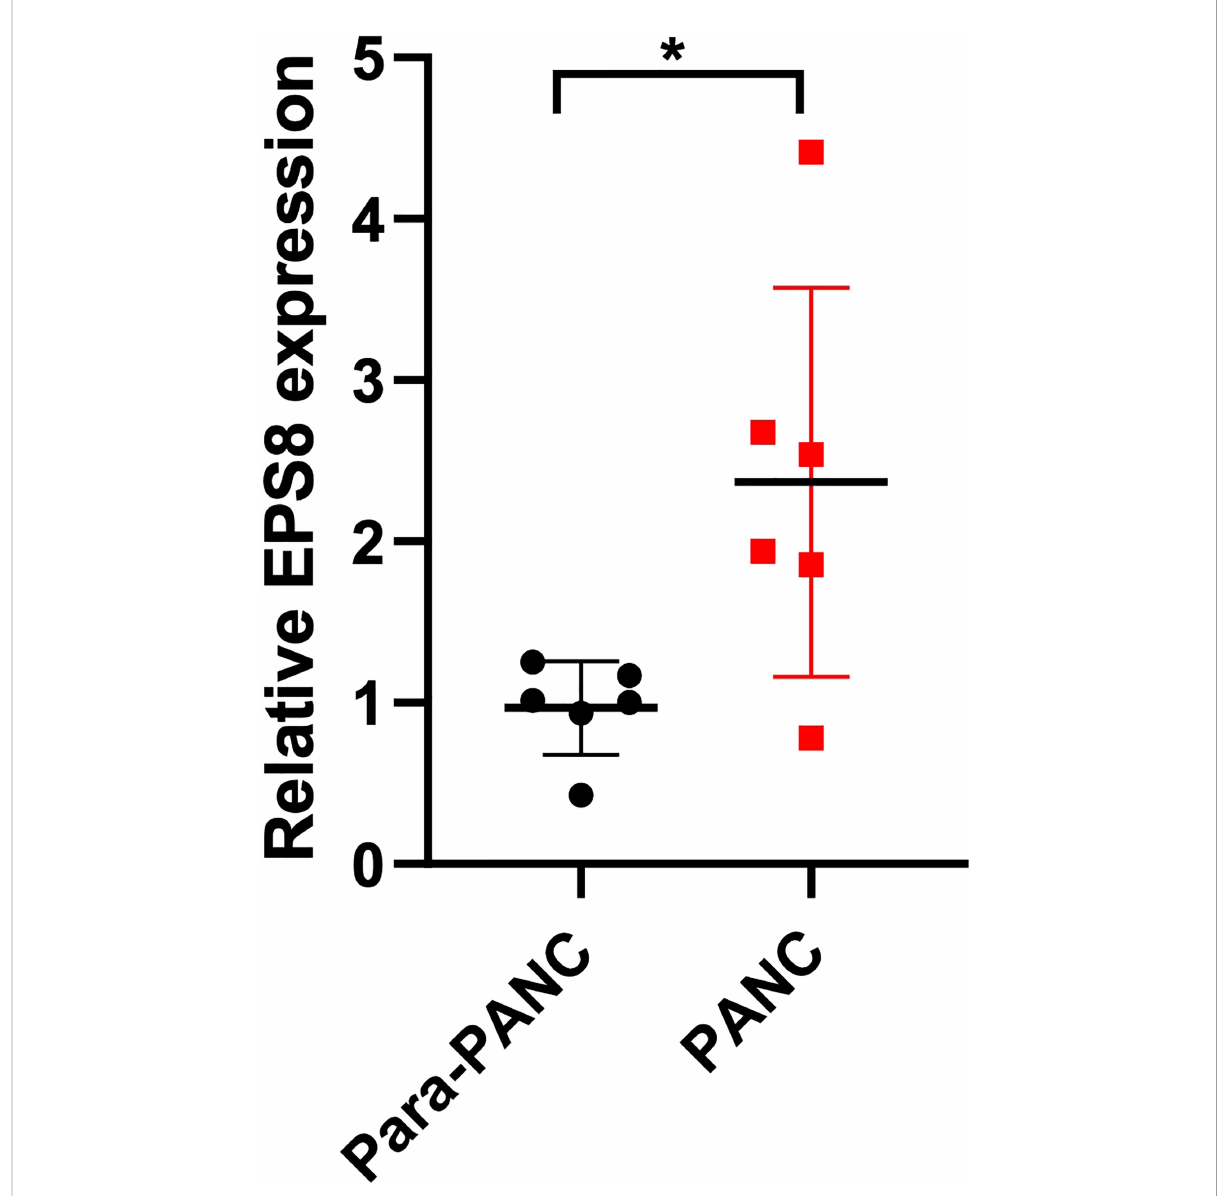
FIGURE 10 Clinical validation of EPS8 expression. The expression of EPS8 was signi fi cantly up-regulated in pancreatic cancer